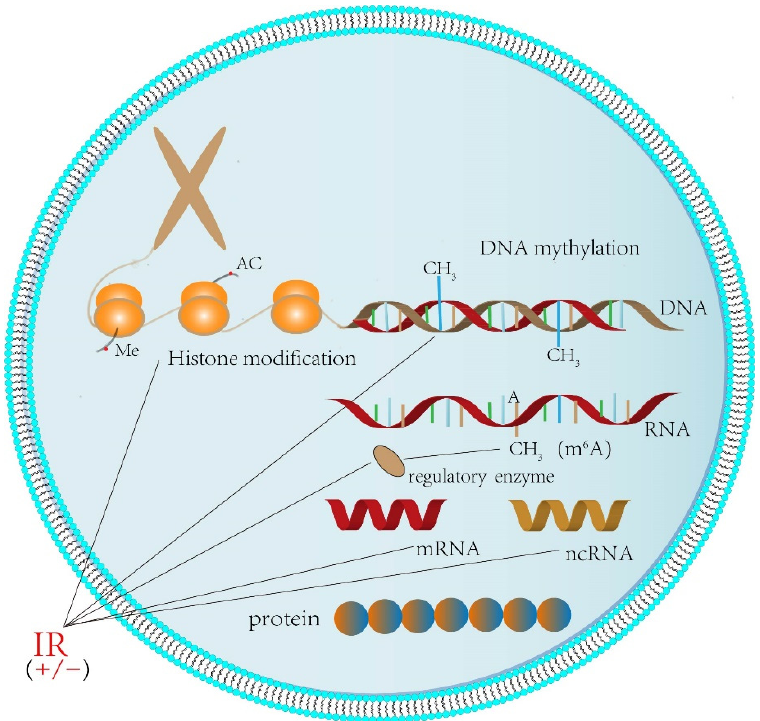
Figure 1. Chromosomes are genetic material in cells and are composed of DNA and proteins, and proteins are mainly histones. DNA can be transcribed and translated into RNA (coding RNA and non-coding RNA) and proteins in cells. Chromatin, histone, DNA and RNA can undergo epigenetic changes such as DNA methylation, histone methylation, histone acetylation and RNA methylation. Studies found that IR can affect cell epigenetics, and it can be applied to DNA and cause DNA methylation levels to be higher or lower. IR also can affect the level of histone methylation, acetylation and tumor cells’ RNA adenosine levels of methylation by acting on enzyme. In addition, it will also affect non-coding RNAs and chromatin remodeling.